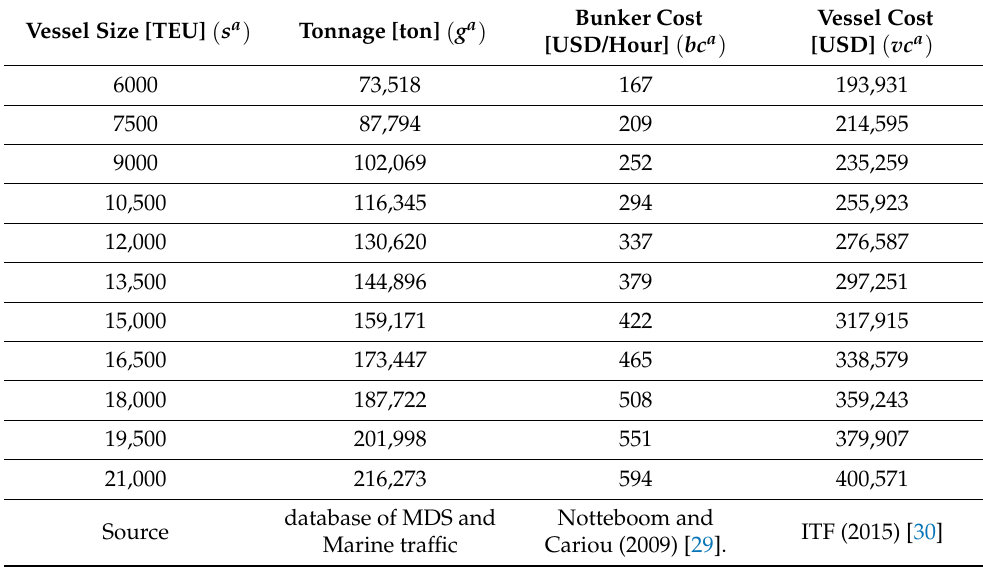
Table 3. Vessel types ( A ).